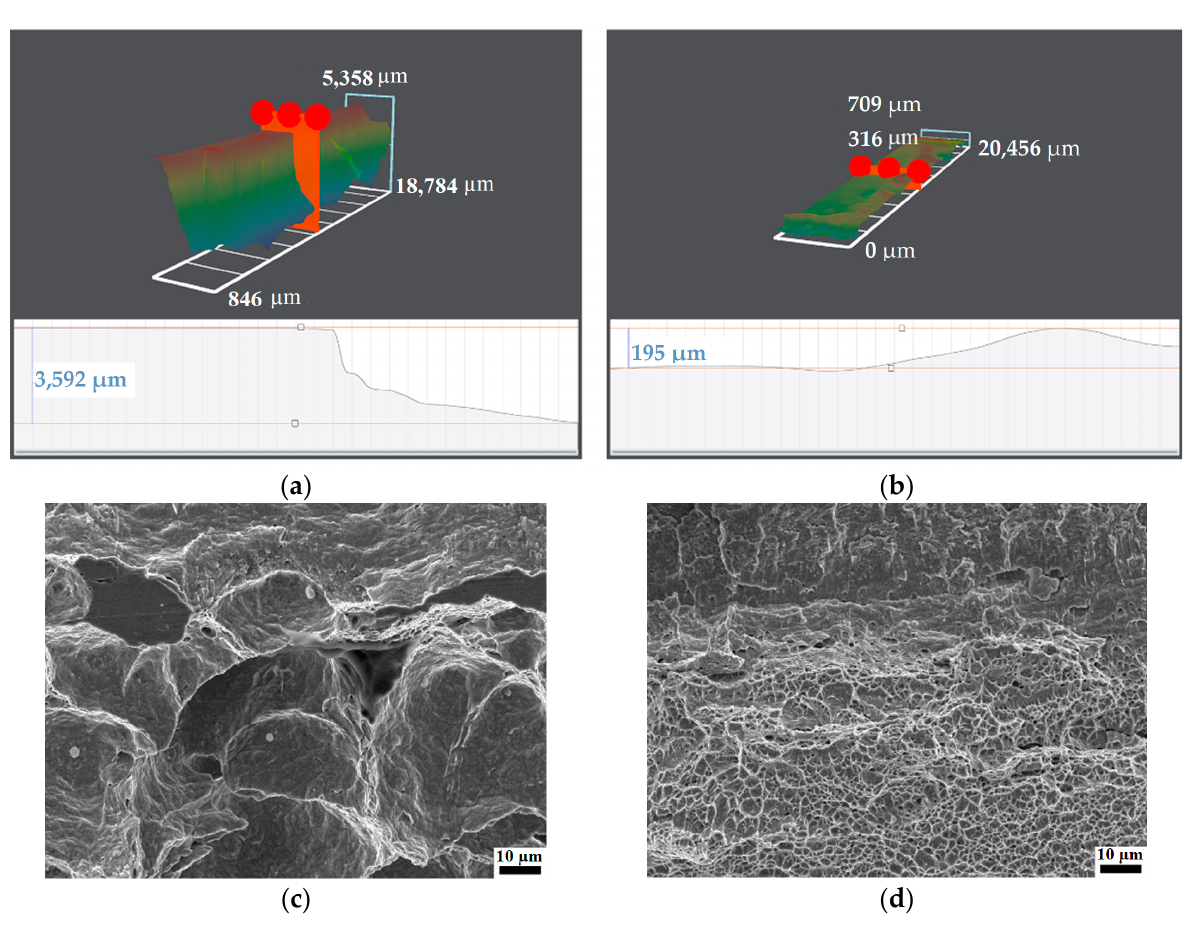
Figure 9. Contour map and fracture morphology of prefabricated fatigue crack tip under two heat input: ( a , c ) ultra-low heat input; ( b , d ) conventional heat input. Table 5. Fracture height difference of prefabricated fatigue cracks under two typical heat inputs. Welding No.